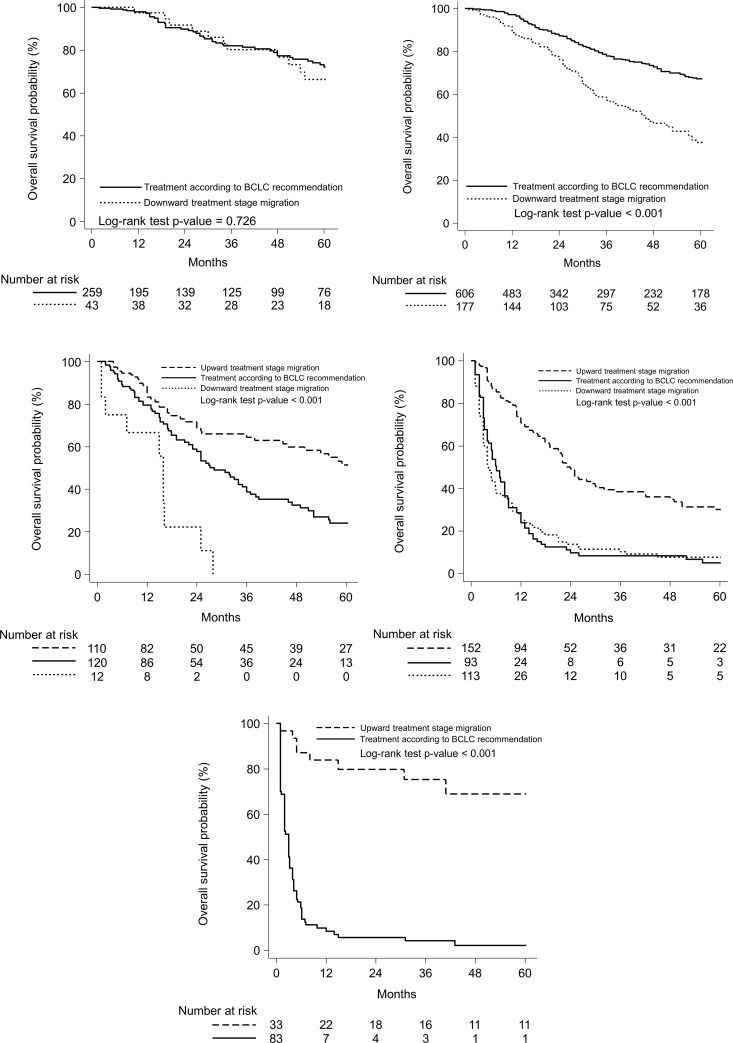
A. Overall survival curves in BCLC 0 patients, according to received treatment. Solid line = Treatment according to BCLC recommendation, median survival 81.1 months (95% CI = 63.9- not available). Dotted line = Downward treatment stage migration. median survival 73.0 months (95%- CI = 55.1-not available). B. Overall survival curves in modified BCLC A patients, according to received treatment. Solid line = Treatment according to BCLC recommendation, median survival 73.0 months (95% CI = 67.8–74.9). Dotted line = Downward treatment stage migration. median survival 45.8 months (95% C I = 36.0–57.1). C. Overall survival curves in modified BCLC B patients, according to received treatment. Dashed line = upward treatment stage migration, median survival 81.1 months (95% CI = 44.8- not available). Solid line = Treatment according to BCLC recommendation, median survival 28.2 months (95% CI = 23.0–36.0). Dotted line = downward treatment stage migration, median survival 15.9 months (95% CI = 1.0–25.0). Upward treatment vs. recommended, p = 0.001; Upward treatment vs. downward, p < 0.001; recommended treatment vs. downward, p = 0.001. D. Overall survival curves in modified BCLC C patients, according to received treatment. Dashed line = upward treatment stage migration, median survival 24.0 months (95% CI = 19.1–30.1). Solid line = Treatment according to BCLC recommendation, median survival 6.1 months (95% CI = 4.9–8.1). Dotted line = downward treatment stage migration, median survival 4.2 months (95% CI = 3.2–5.9). Upward treatment vs. recommended, p < 0.001; Upward treatment vs. downward, p < 0.001; recommended treatment vs. downward, p = 0.812. E. Overall survival curves in modified BCLC D patients, according to received treatment. Dashed line = upward treatment stage migration, median survival not reached (95% CI = 40.9-not available). Solid line = Treatment according to BCLC recommendation, median survival 2.9 months (95% CI = 2.0–3.2).